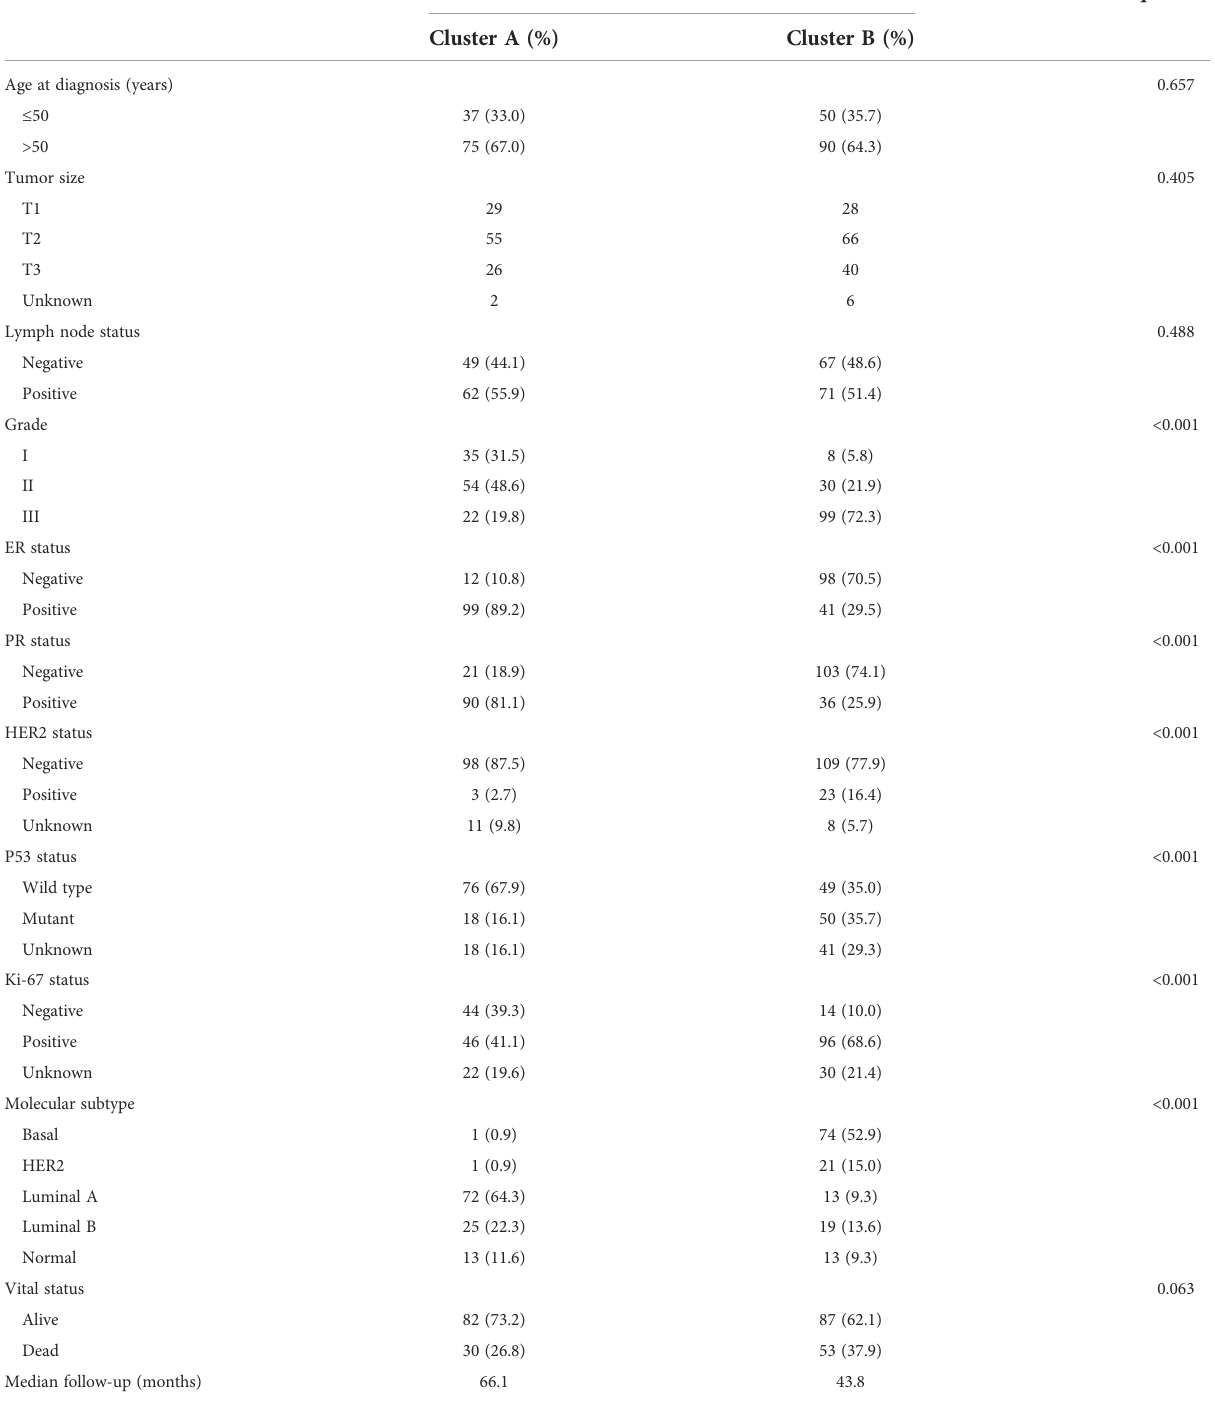
TABLE 1 Clinicopathologic characteristics of breast cancer patients according to the senescence